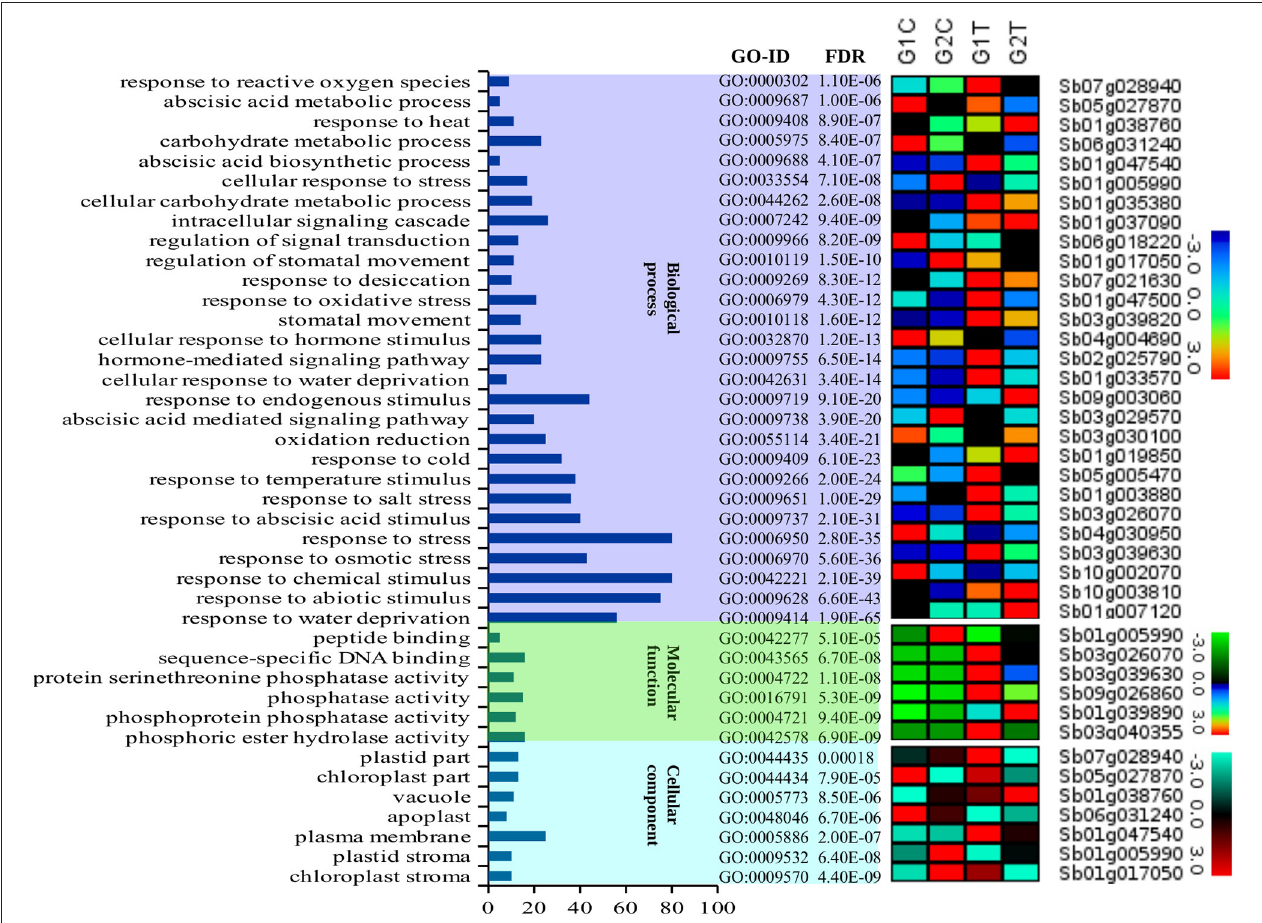
FIGURE 1 | A description of the GO enrichment analysis and corresponding gene expression profile. The figure summarizes a description of the three main GO categories namely biological process, molecular function and cellular component and 41 sub-categories for the GO-terms assigned to the sorghum genes that were involved in drought associated pathways and the corresponding genes that were up and down regulated under drought condition. The different color background shows the different classes of GO categories (x-axis). The number of genes classified in each GO category are shown in the y-axis. To indicate the enrichment level of the GO-terms in the GO categories, we show the associated GO-IDs and the corresponding p -values (FDRs). The expression pattern of 41 representative genes to which the corresponding categories of GO-terms were assigned was based on the leaf tissue of 2 sorghum varieties